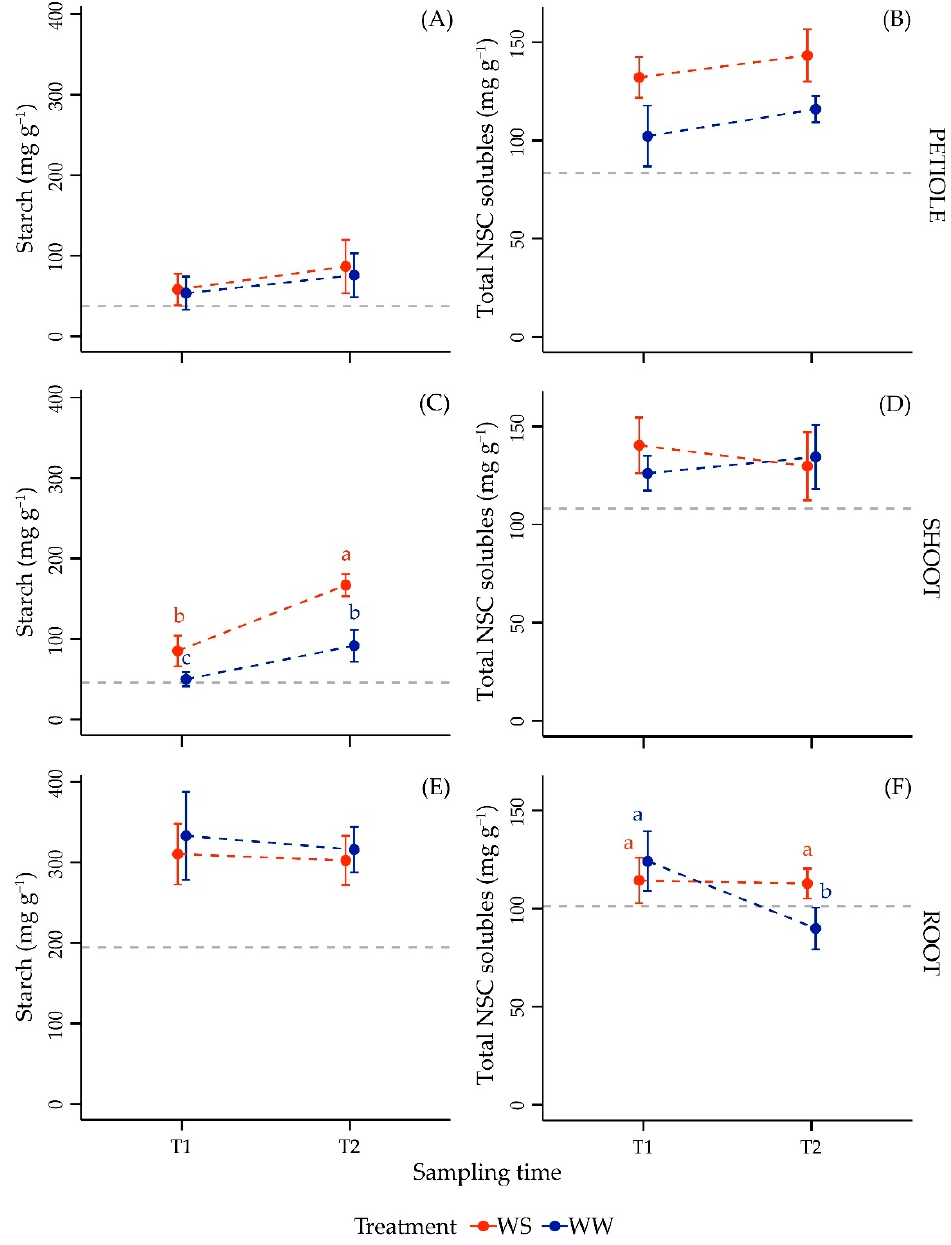
Figure 4. Mean values ± standard deviation of starch and total NSC soluble concentration in petiole (panels A and B ), in shoot (panels C and D ) and root (panels E and F ) in Merlot vines under well- watered (WW) and water stress (WS) conditions at sampling times T1 and T2 (237 and 260 DOY). The horizontal dotted line indicates the value of the variables at T0 (205 DOY). Different letters correspond to statistically significant differences ( p < 0.05).